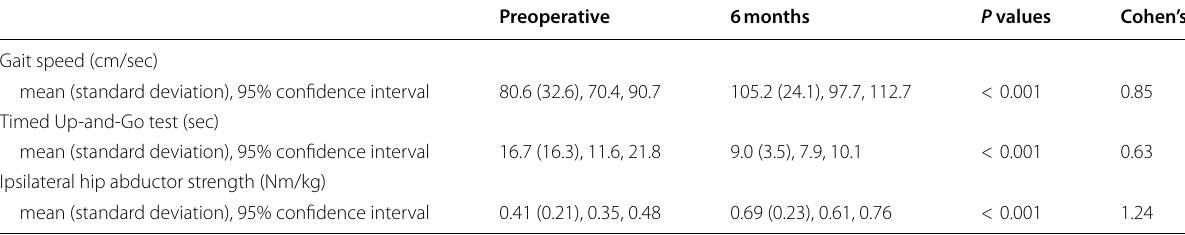
Table 2 Postoperative alterations in gait function and muscle strength